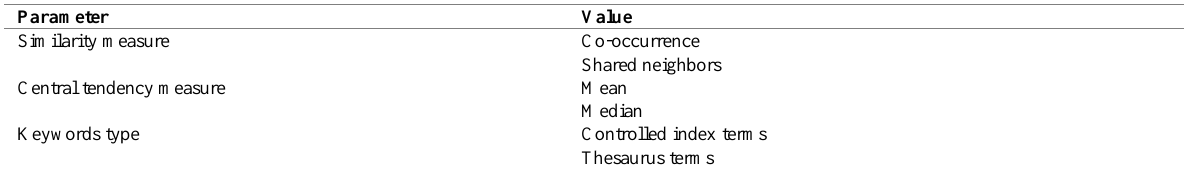
Table 3. Assessment configuration parameters.